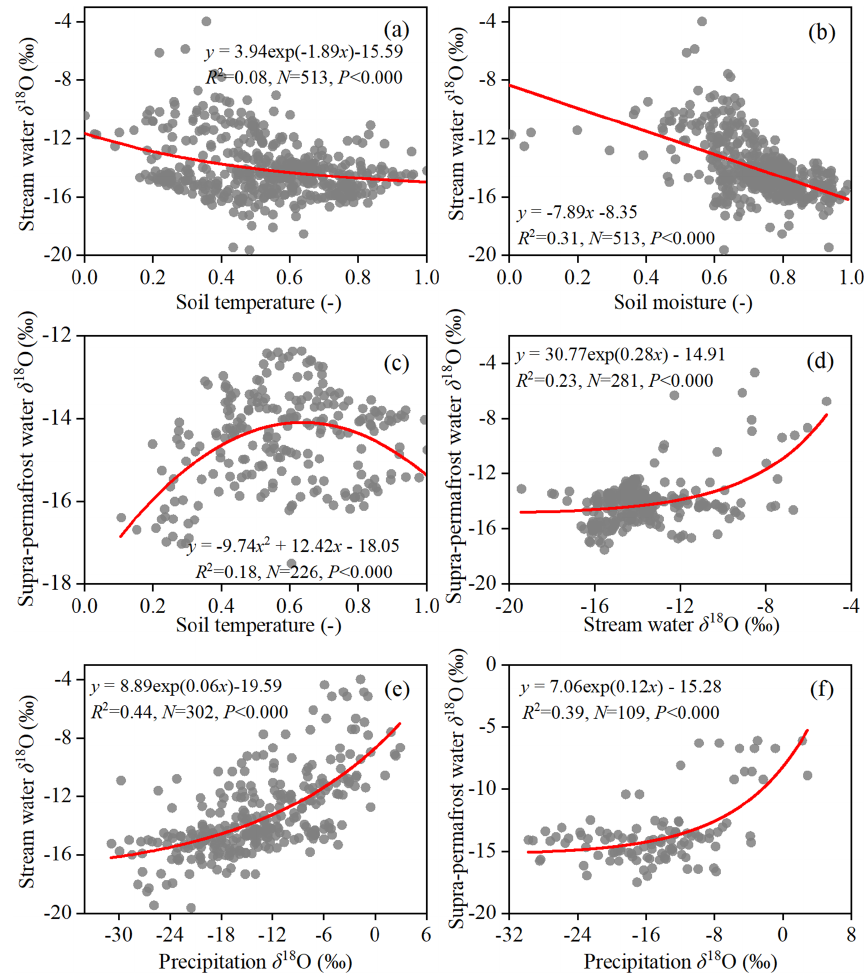
Figure 5. Correlation analysis between stable isotopes and influencing factors. Panels (a) and (b) are correlations between stream water δ 18 O with soil temperature and moisture, respectively; (c) and (d) correlations between supra-permafrost water δ 18 O with soil temperature and stream water δ 18 O, respectively; (e) and (f) correlations between precipitation δ 18 O with stream and supra-permafrost water δ 18 O, respectively. The red line is the fitted line. Soil moisture and temperature data used in correlation analysis were normalized. “–” indicates dimensionless. The soil moisture and temperature data were the daily average value of all the sensor data in the soil